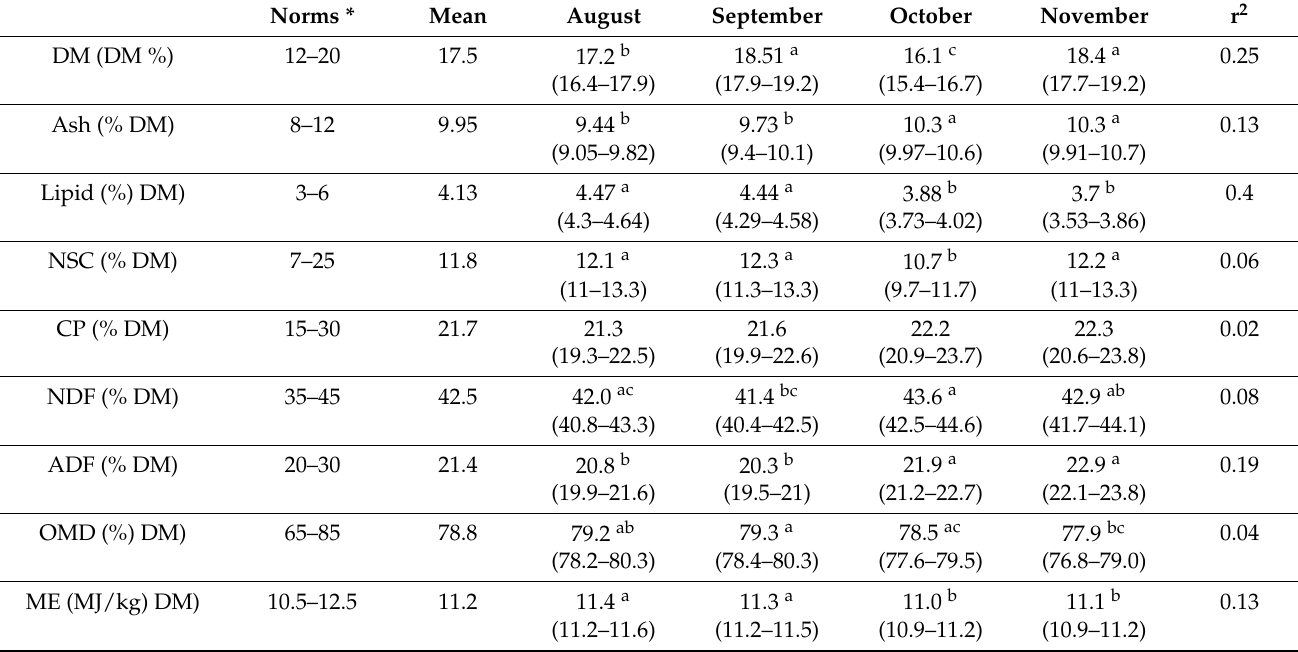
Table 3. The herbage quality (nutritional composition; mean ± 95% confidence interval) over the entire study period (winter–spring) (linear mixed model analysis; n =